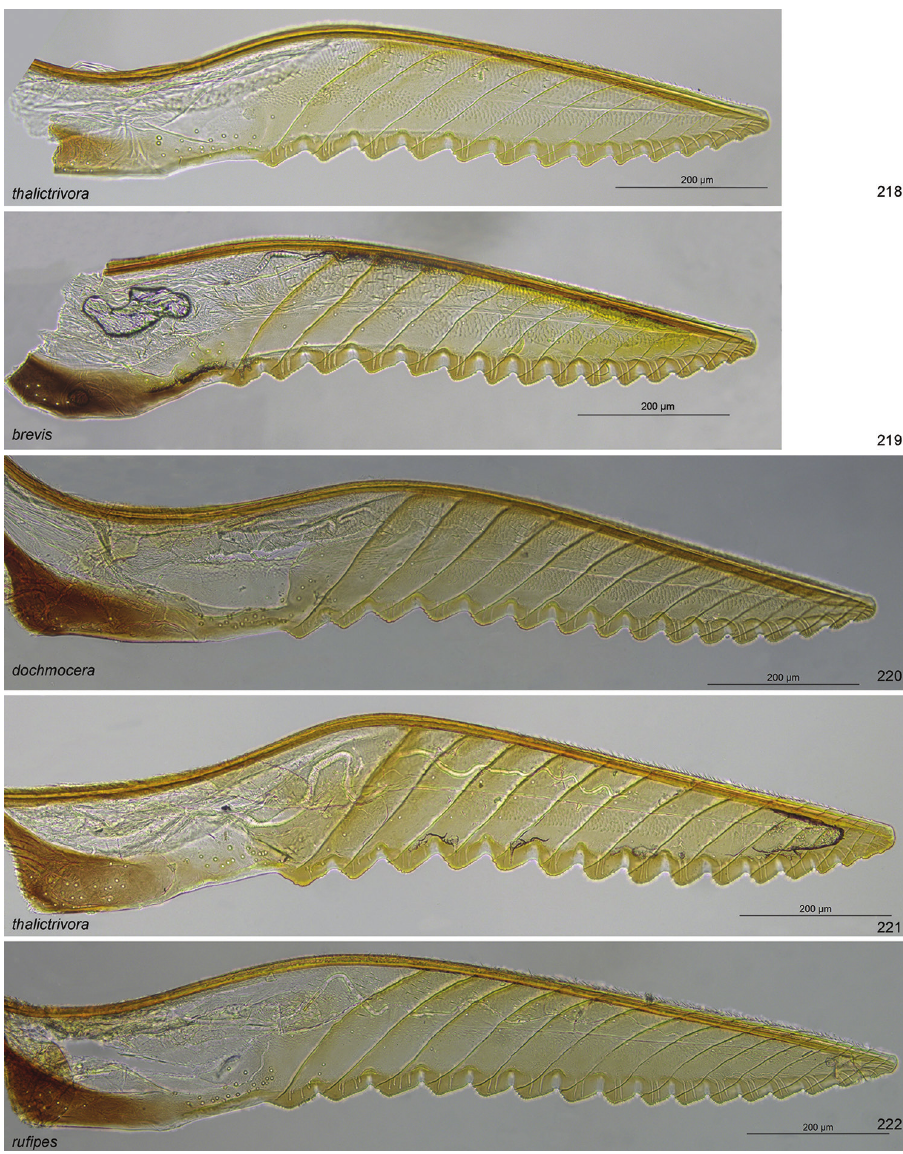
Figures 218–222. Lancets of Pristiphora . 218 thalictrivora , holotype of thalictricola 219 brevis DEI- GISHym31261 220 dochmocera lectotype 221 thalictrivora DEI-GISHym20854 222 rufipes DEI-